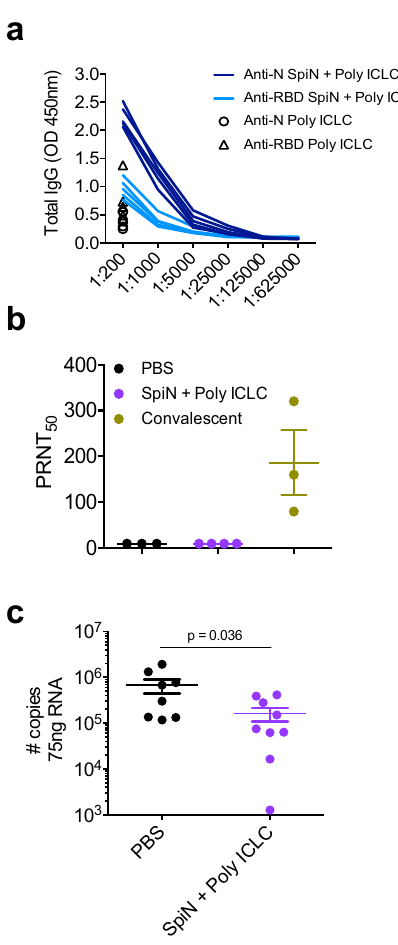
Fig. 5 | Protective immunity in hamsters immunized with SpiN and challenged with SARS-CoV-2. a The levels oftotal IgG anti-N and anti-RBD in sera ofhamsters vaccinatedwithSpiNassociatedtoPolyICLC. b Levelsofneutralizingantibodiesin the sera from hamsters vaccinated with SpiN + Poly ICLC, in comparison with sera from convalescent individuals. c Viral load measured by RT-PCR in the lungs of controland hamstersimmunized with SpiN plus PolyICLCat4 days post-infection (dpi) with SARS-CoV-2. Data are presented as mean+/- SEM (b , c) . d Histopathological analysis at2,5x,5x, and 20xmagni fi cationofhamstersat4dpi with the Wuhan strain, shows that the lungs in the PBS group display an accen- tuated diffuse alveolar wall thickening, with moderate multifocal collapse